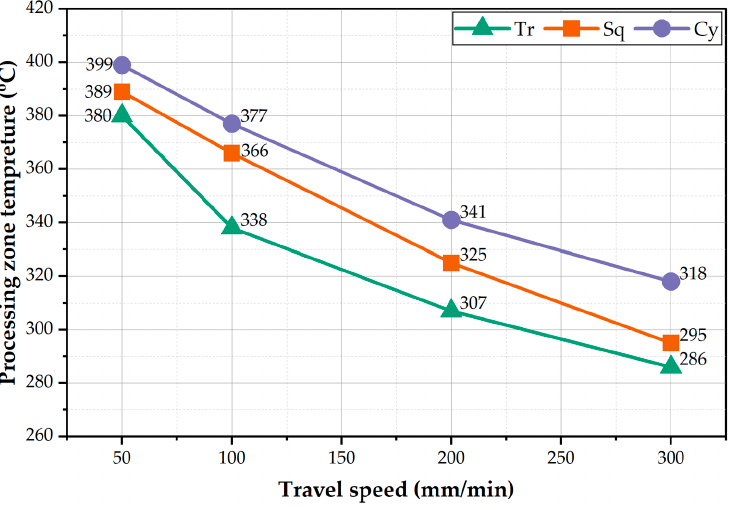
Figure 6. PZ temperature against travel speed at the used different pin